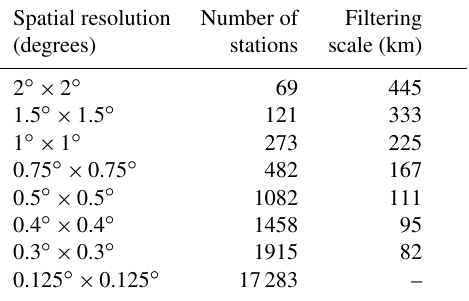
Table 2. Spatial resolution (degrees) and associated number of sta- tions of the different sub-sampled fields used to reconstruct the SLA in the Mediterranean. The lower row displays the spatial resolution and stations of the original altimetry maps. The filtering scale (km) used to compute the recovered SLA fields in the different recon- structions have been also included. Spatial resolution Number of